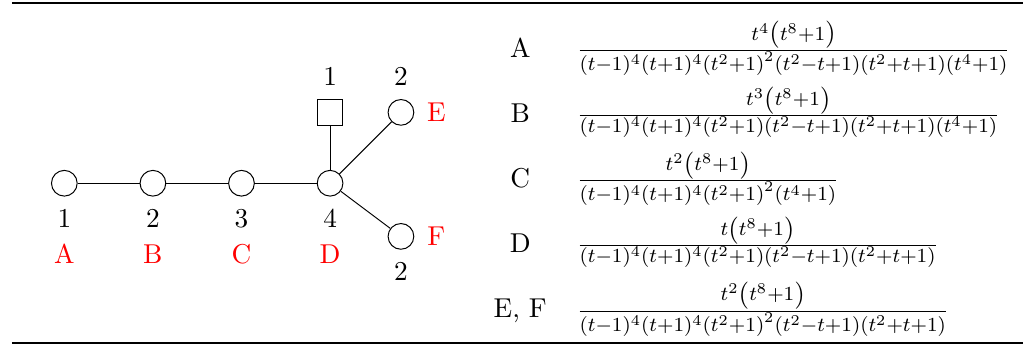
Table 11. Sp(2) with N f = 6 . B-twisted index with Wilson lines at the labelled position in the